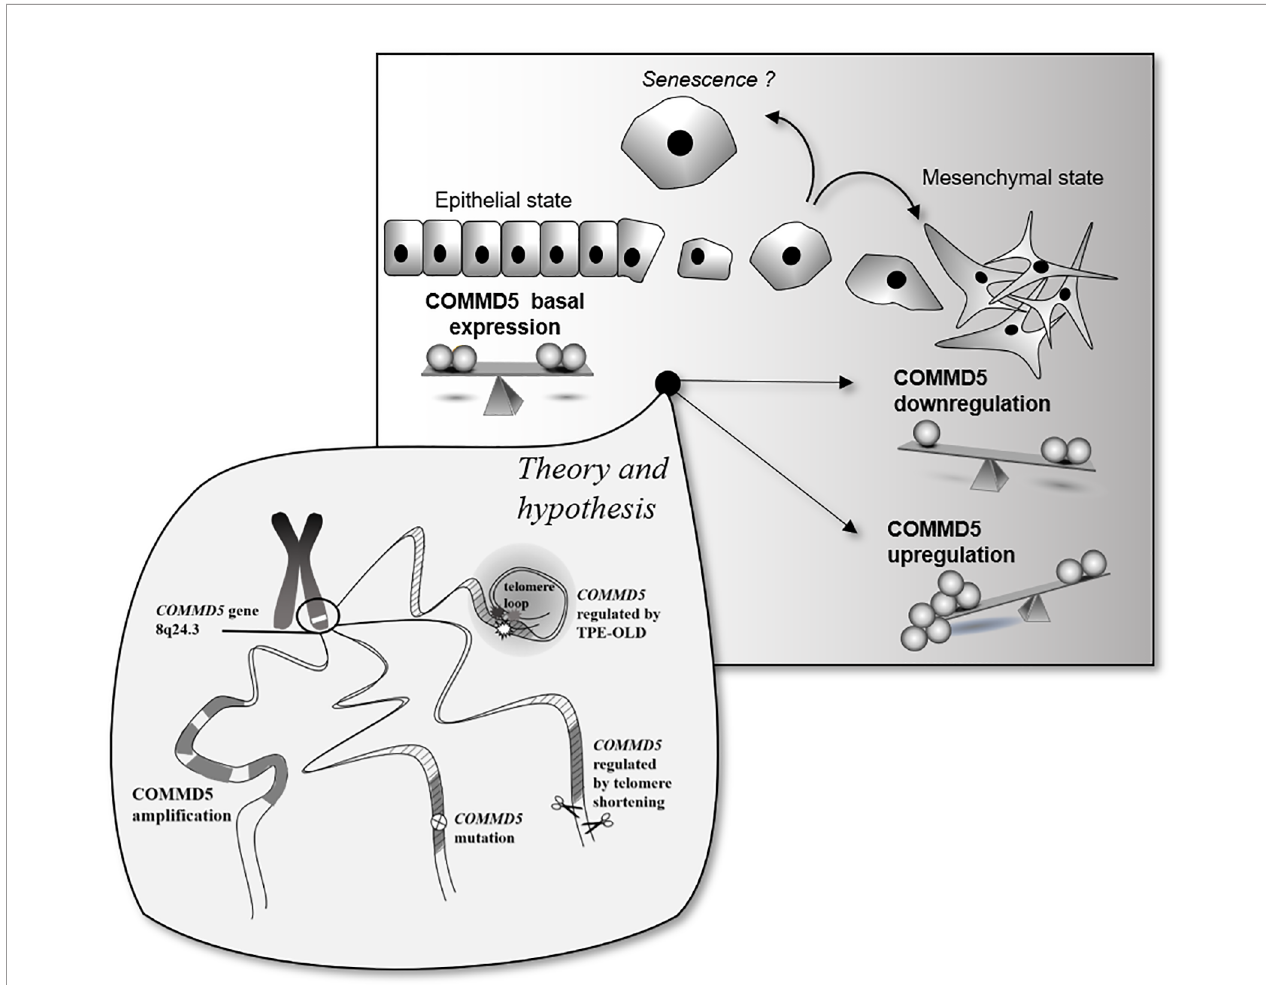
FIGURE 7 | Schematic representation of putative COMMD5 expression pro fi le and cell status. COMMD5/HCaRG plays an essential role in the establishment and maintenance of the epithelial cell phenotype. Downregulation of COMMD5 or complete loss of COMMD5 expression or function by mutations induce an epithelial to mesenchymal transition. On the other hand, too much of COMMD5 is also deleterious to cells. COMMD5 is localized at the extreme end of the chromosome 8, a region highly targeted by locus ampli fi cation. We propose here that its subtelomeric localization could explain the variable expression of COMMD5 in cancer. Gene ampli fi cation, mutation, and proximity to telomere are all events that may contribute to regulation of COMMD5 expression in cancer. Consequently, as COMMD5 is involved in crucial cellular functions such as cell differentiation, proliferation, and migration, expression of this gene must be tightly